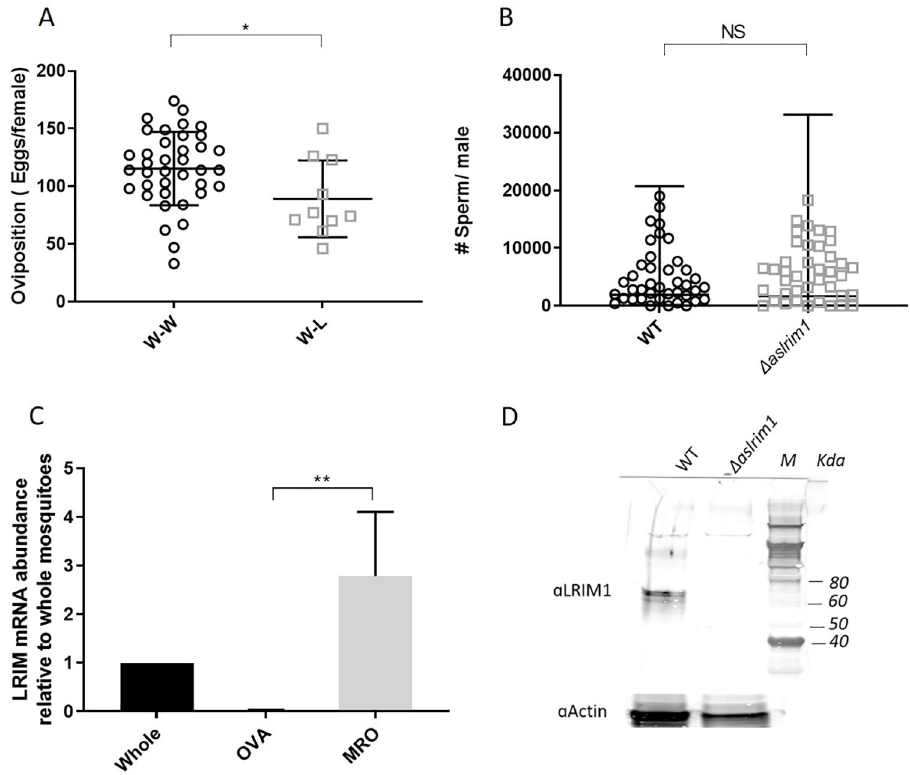
Fig 4. Effect of deletion of LRIM1 on fertility in male mosquitoes. (A) Number of eggs laid in single Drosophila tubes by WT females, mated with WT (W-W) or Δ aslrim1 (W-L) males. The results are the mean number ± SD (n = 38 and 10 for W-W and W-L, respectively). Results were analyzed by unpaired t-test. (B) The number of sperm/ male was determined by dissecting the male testes and accessory glands from each male and counting the number of sperm in a hemocytometer under the microscope. The results are presented as the geometric mean ± SD (n = 40 and 31 for WT and Δ aslrim1 respectively) and are representative of 2 independent biological repeats with similar results. The data were analyzed using non-parametric, Mann Whitney test. Since some values were zero, a value of 1 was added to the entire dataset to allow calculation of the geometric means. (C) Relative abundance of LRIM1 mRNA in ovaries (OVA) and male reproductive organs (MRO) of WT mosquitoes was determined by real-time PCR using primers specific to LRIM1 (Primers 5 and 6, S6 Table). The abundance was normalized to the mosquito S7 ribosomal protein gene (Primers 9 and 10, S6 Table). �� P � 0.01. The results shown here are representative of two independent biological repeats, using RNA extracted on two different occasions. (D) Western blot analysis done on pools of male reproductive organs (MRO) from 30 WT and Δ aslrim1 male mosquitoes. The proteins were transferred to PVDF membrane and reacted with 1:250 rabbit polyclonal anti LRIM1, generated in this work. Beta actin (1:1000) was used as a loading